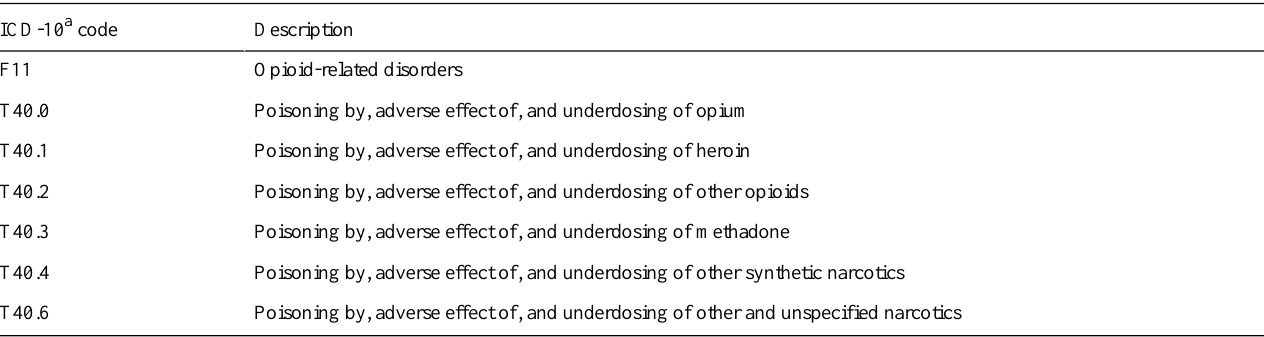
Table 1. List of International Classification of Diseases, Tenth Revision (ICD-10) codes for opioid-related diagnoses used for Algorithm 1 case